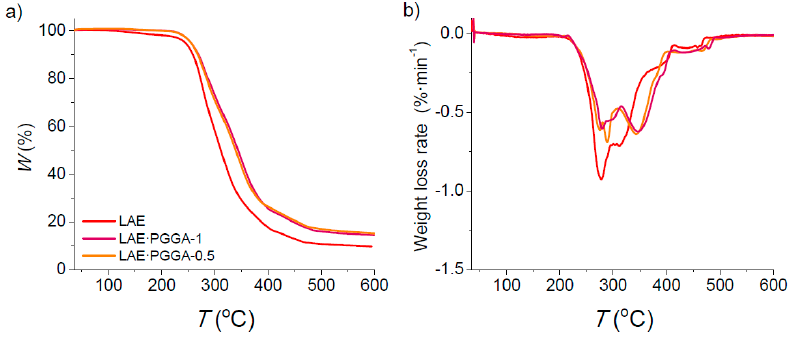
Figure 3. Thermogravimetric analysis (TGA) traces ( a ) and derivative curves ( b ) of LAE and its ionic complexes with PGGA.